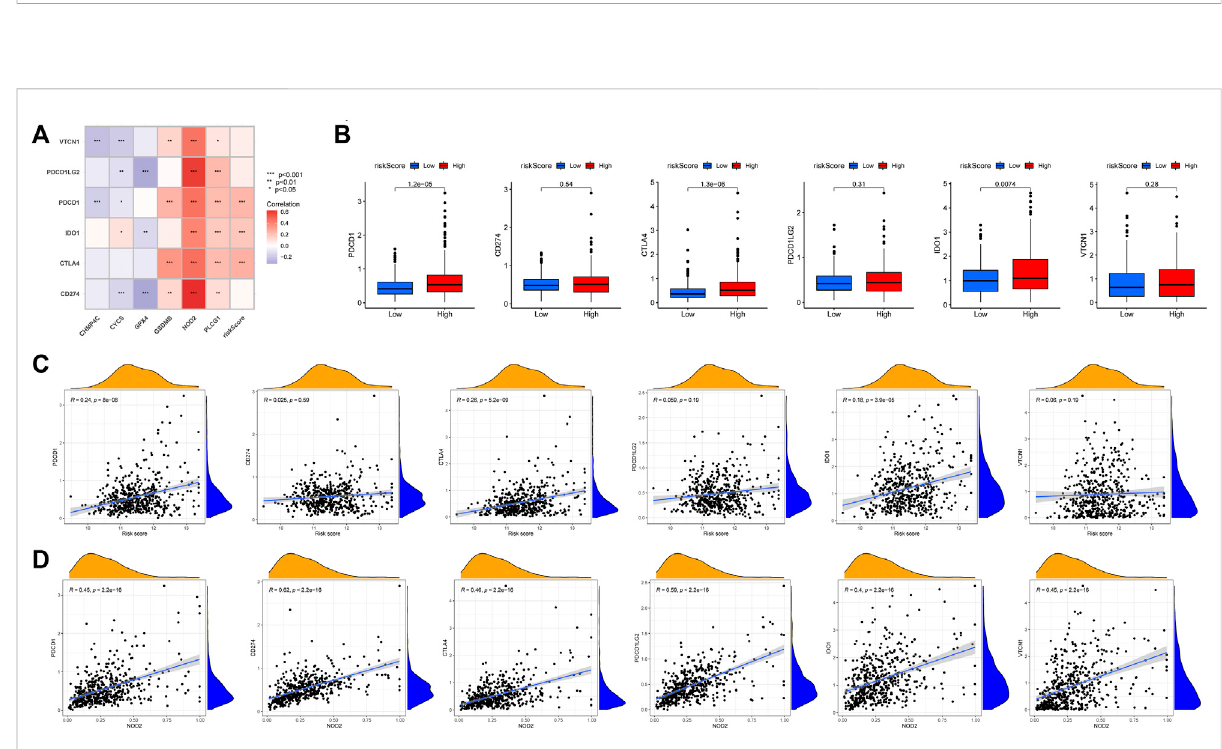
FIGURE 13 The relationship between immune checkpoint-related genes and risk score. (A) Heatmap of correlations between immune-check genes and central genesand risk score. (B) PD-1, CTLA4 andIDO1 werehighly expressedinthehigh-risk group. The correlation betweenimmune checkpoint- related genes and risk score (C) and NOD2 (D)